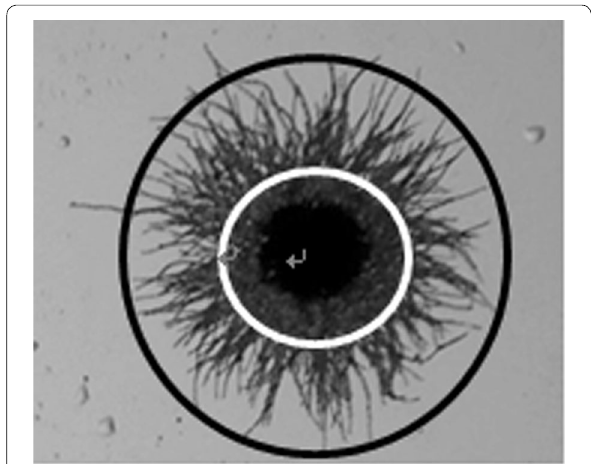
Fig. 2 Schematic diagram of a typical pellet formed in seed culture of A.